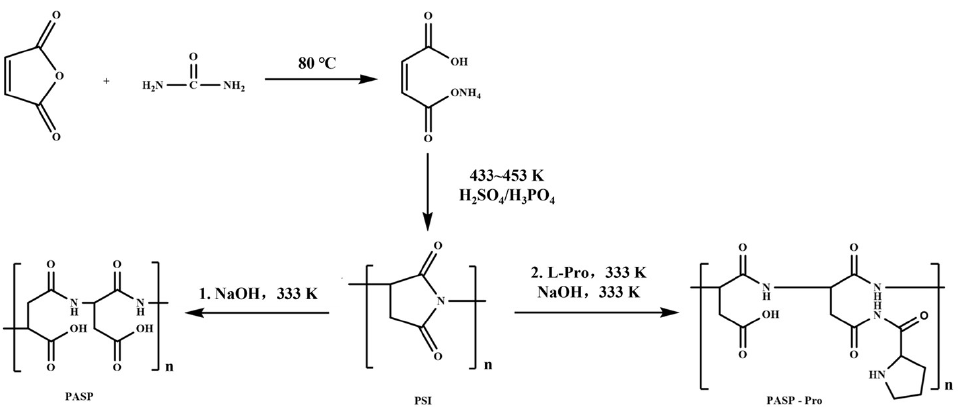
Figure 1. Synthesis routes of PASP and PASP-Pro copolymers. n, represents the repeating units of the polymers. the